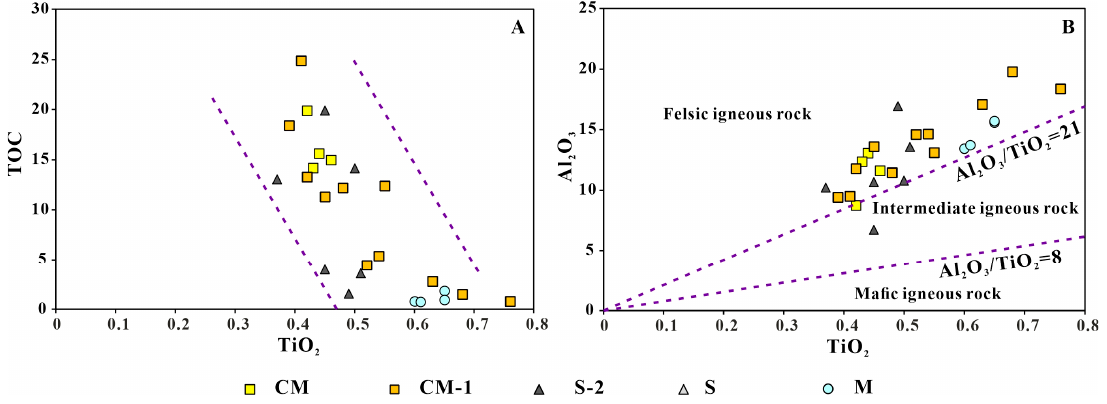
Figure 10. ( A ) Crossplots of TiO 2 versus TOC contents. ( B ) Crossplots of TiO 2 versus Al 2 O 3 contents for detrital input of the Chang 7 Member in the Ordos Basin. for detrital input of the Chang 7 Member in the Ordos